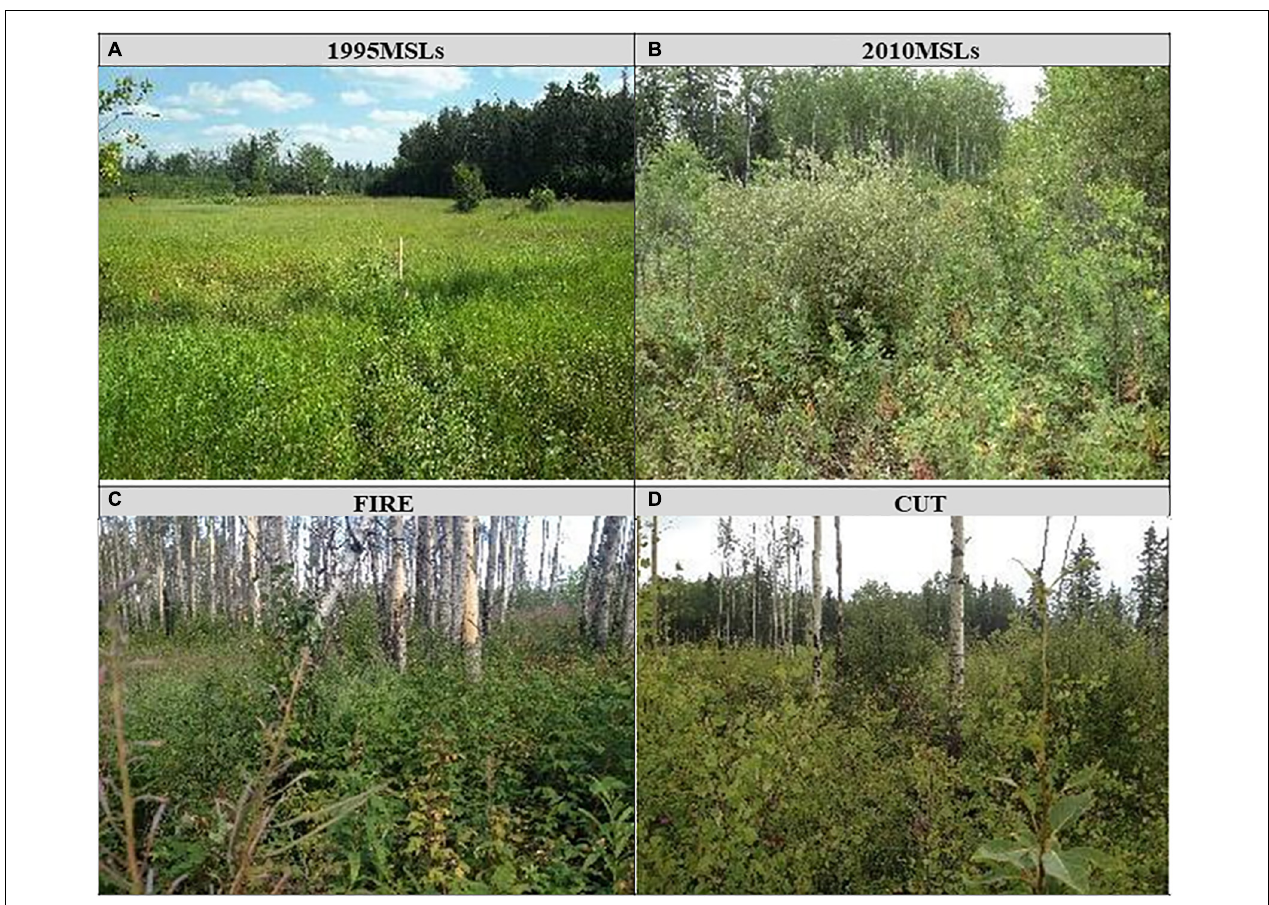
FIGURE 1 | Images showing the general status of the two certified reclaimed mineral lease surfaces and adjacent reference sites in Alberta’s Central Mixedwood, Dry Mixedeood, and Lower Boreal Highlands Natural Subregions: (A) 1995MSL, (B) 2010MSL, (C) FIRE, and (D)